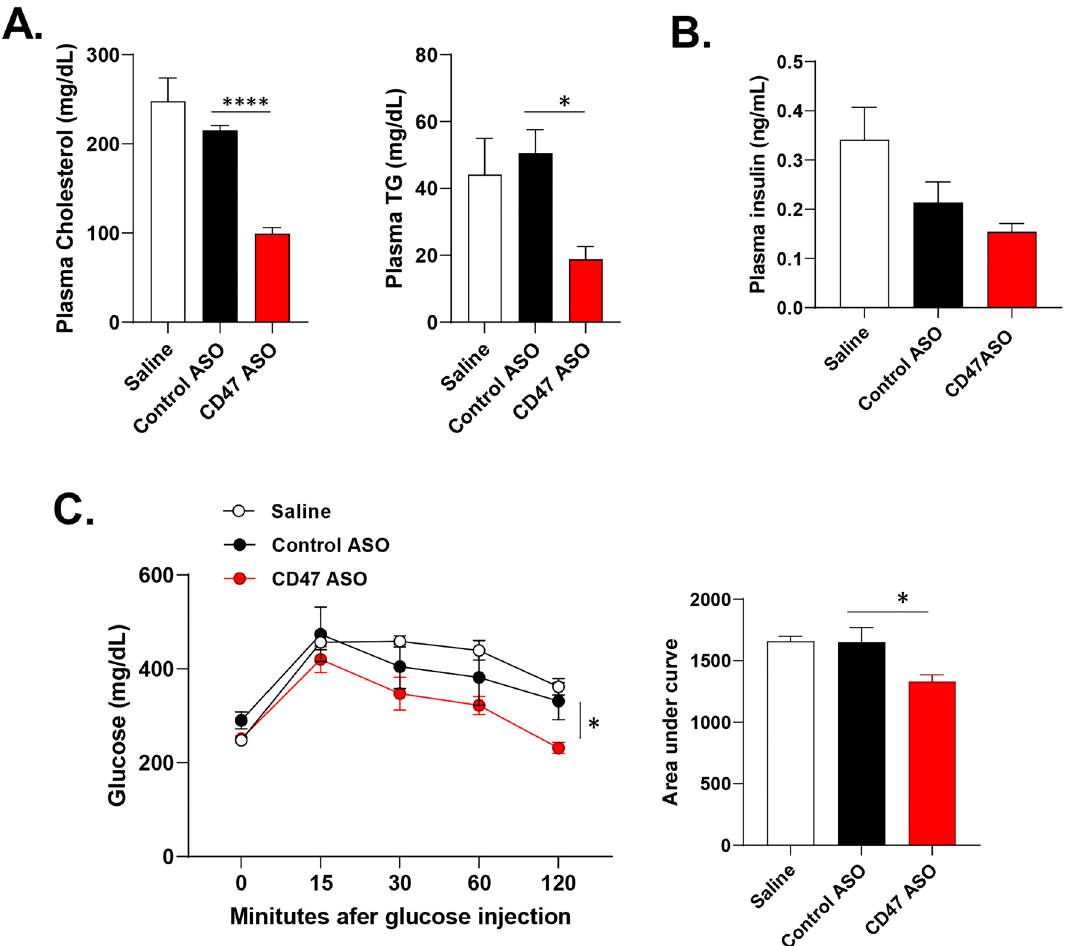
Figure 2. CD47ASO treatment reduced hyperlipidemia and improved glucose tolerance in diet-induced obese mice. ( A ) Plasma total cholesterol and triglyceride levels; ( B ) plasma insulin levels; ( C ) Glucose tolerance test (GTT) and area under the curve were analyzed. Data are represented as mean ± SE (n = 4–7 mice/group). * P < 0.05, **** P <